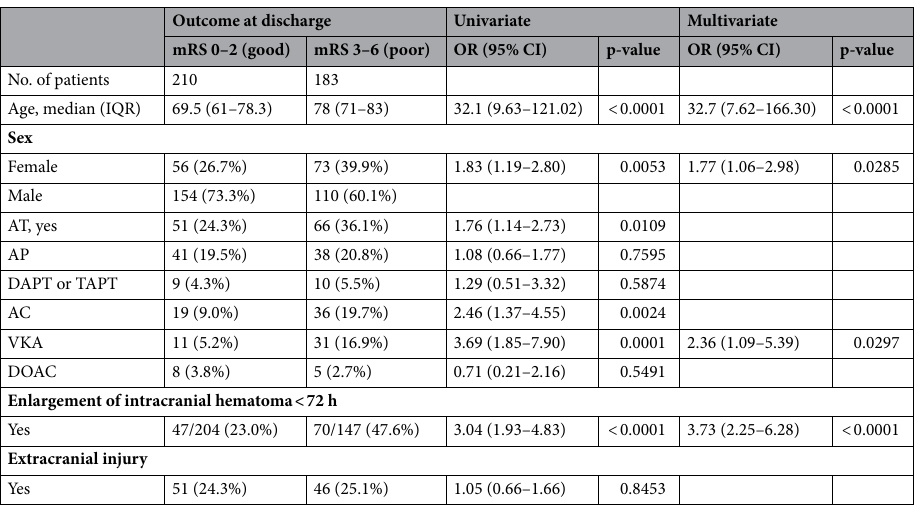
Table 2. Results of the univariate and multivariate analysis of the risk factors associated with poor outcome in patients with tICH. AC anticoagulant agents, AP antiplatelet agents, AT antithrombotic agents, DAPT dual antiplatelet therapy, DOAC direct oral anticoagulants, IQR interquartile range, mRS modified Rankin scale score, OR odds ratio, TAPT triple antiplatelet therapy, VKA vitamin K antagonist.